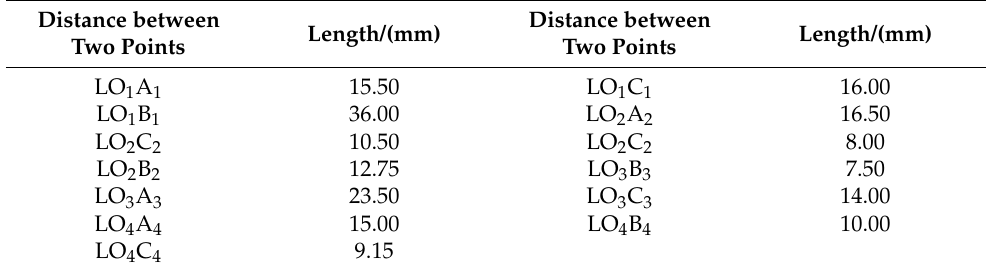
Table 5. Size parameters of outside opening kinematic chain